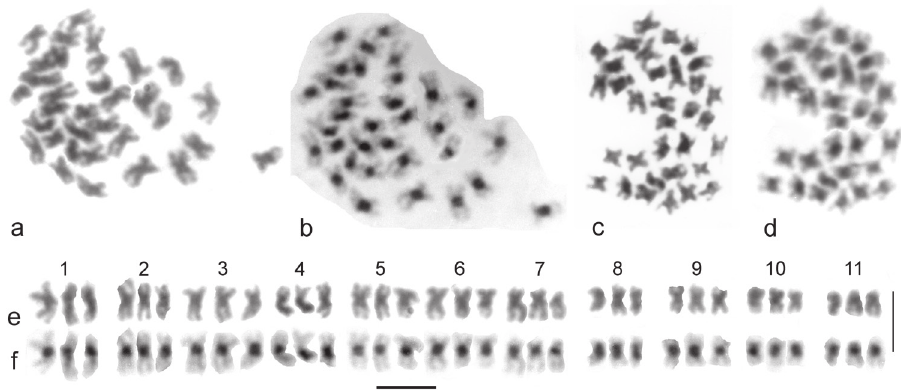
Figure 4. Cantabrogeus triploid species, mitotic chromosomes from mid-gut nuclei. a–d the chromo- somes as found a , c unbanded b , d the same nuclei C-banded e , f karyotypes assembled from the nucleus figured in a & b . Scale bar = 5 µm.